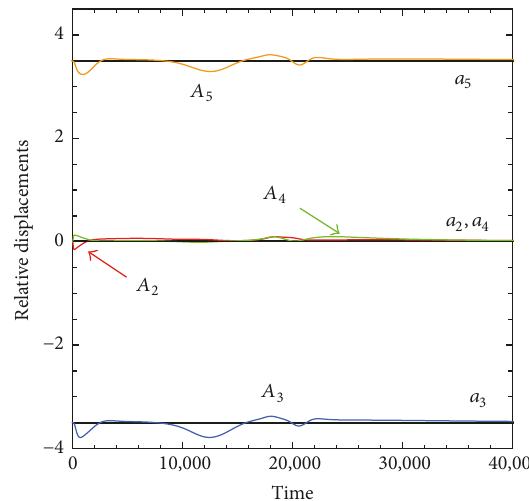
Figure 15: Relative distance error, 𝐴 𝑘 to 𝑎 𝑘 for Scenario 3.